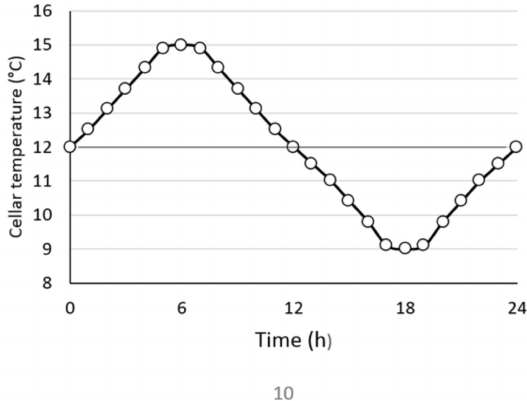
Figure 5. Evolution of the cellar temperature according to time on a 24 h